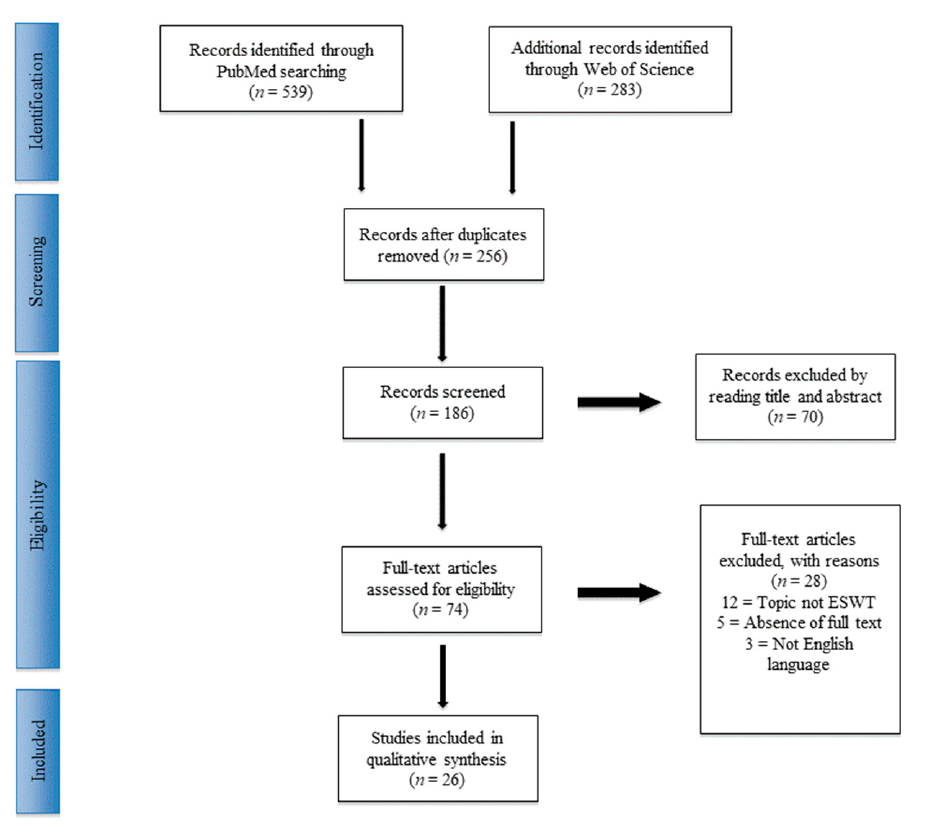
Figure 1. PRISMA (Preferred Reporting Items for Systematic Reviews and Meta-Analysis) flowchart of the systematic literature review .